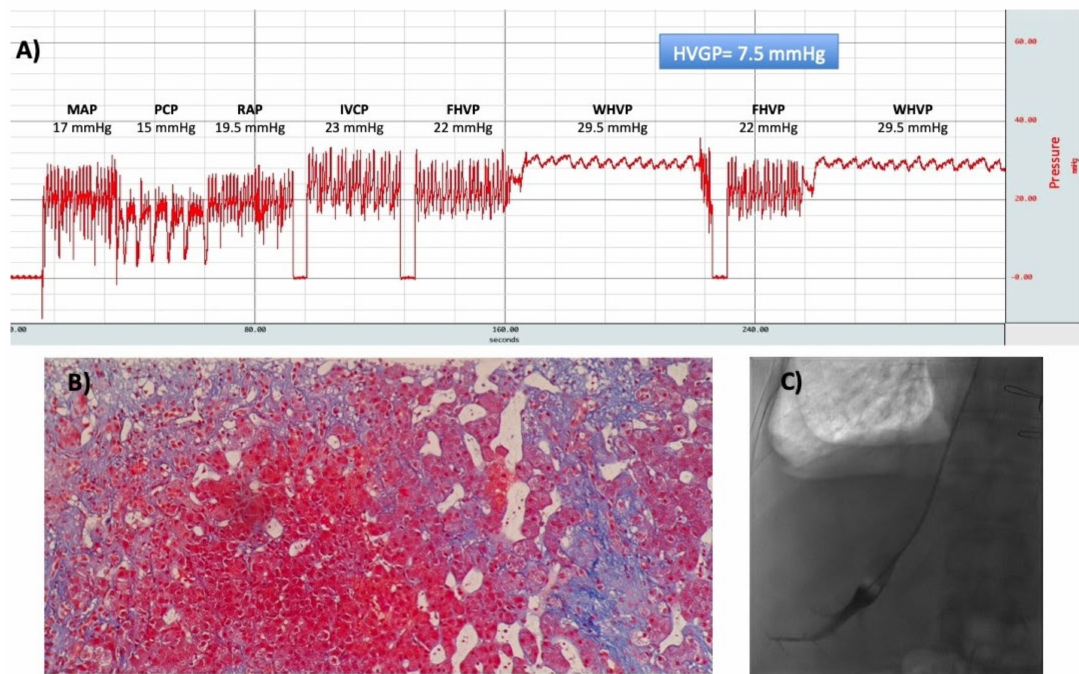
Figure 9. ( A ) A typical hemodynamic tracing of a patient with severe tricuspid regurgitation and concomitant hepatitis C. The HVPG is calculated as the di ff erence between WHVP and FHVP. Both of them are elevated, and the HVPG is slightly elevated. ( B ) Transjugular liver biopsy was performed and showed significant fibrosis forming nodules (Masson stain, × 10 objective). ( C ) Occlusion of the hepatic vein with the balloon catheter. Abbreviations: MAP: mean pulmonary arterial pressure; PCP: pulmonary capillary pressure; RAP: right atrial pressure; IVCP: inferior vena cava pressure; FHVP: free hepatic venous pressure; WHVP: wedged hepatic venous pressure; HVPG: hepatic venous pressure